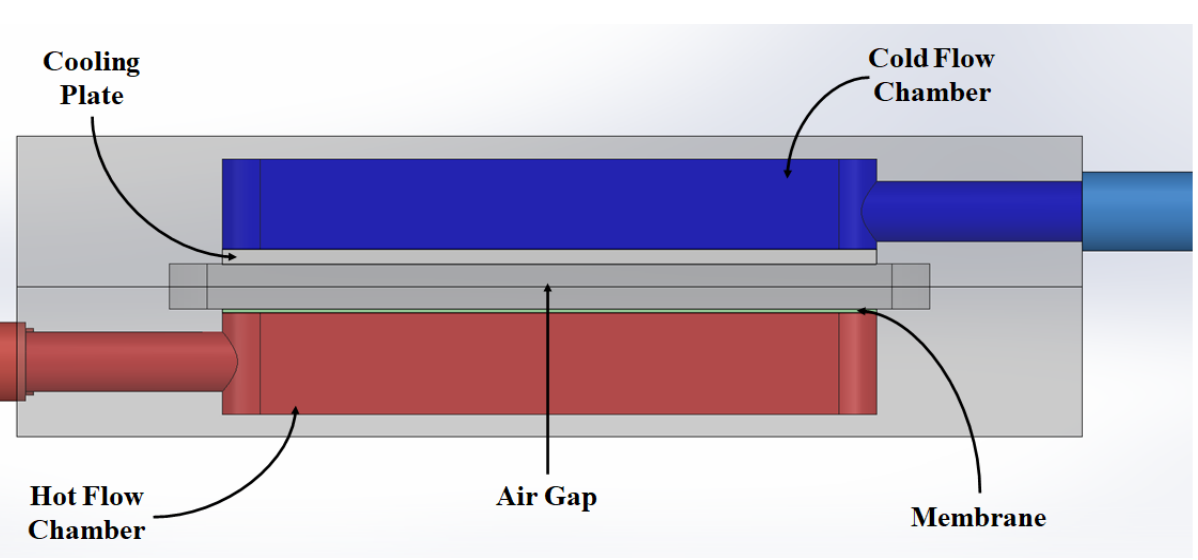
Figure 4. Proposed AGMD module.